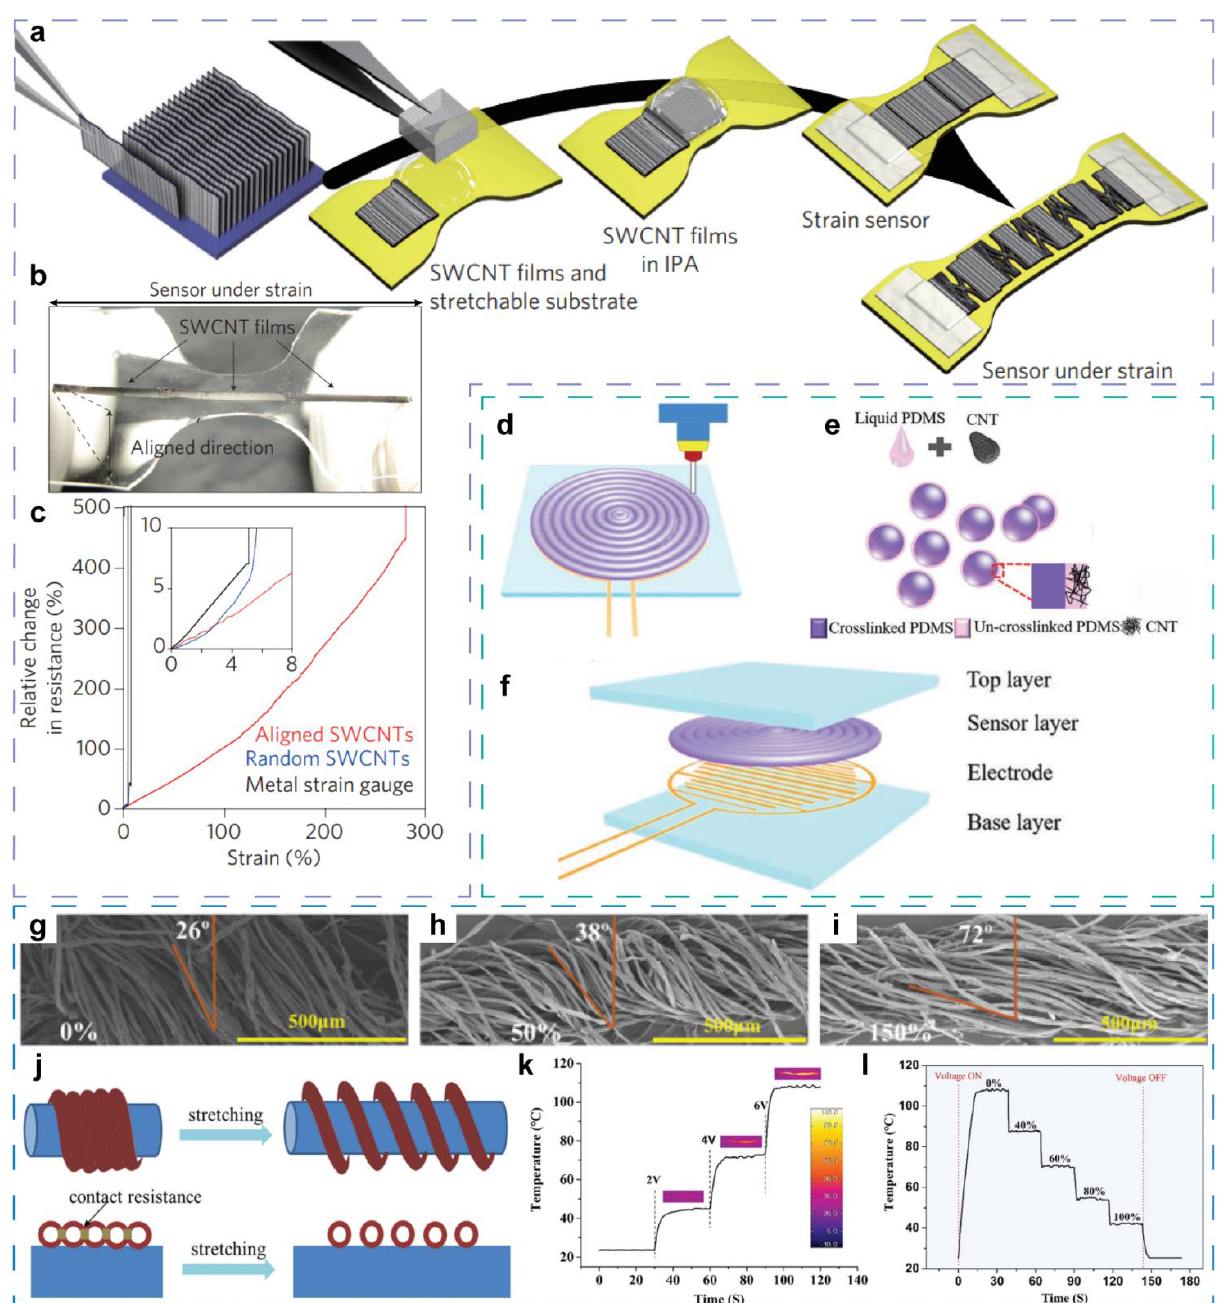
Figure 3. Multifunctional mechanical sensors employing 1-D conductive materials as sensing components. ( a ) Fabrication steps of the SWCNT strain and bending sensor. ( b ) Photograph of the SWCNT sensor. ( c ) Relative change in resistance of aligned under strain up to 280%. The inset is magnification of the low-strain region, showing the details for sensor based on random SWCNTs and conventional metal thin film. Reproduced with permission. [62] Copyright 2011, Springer Nature. ( d ) Schematic of 3D-printing method for the piezoresistive sensor based on PDMS MPs and CNTs that mimics the texture and sensitivity of human skin. ( e ) The new type of 3D-printing ink for fabricating the sensor, containing PDMS MPs, uncured PDMS precursor, and CNTs. ( f ) Structure diagram of the PDMS/CNT composite sensor. Reproduced with permission. [58] Copyright 2019, Wiley-VCH. ( g – i ) SEM image of the Ag NWs/CPY sensor under strain of 0%, 50%, and 150%, respectively. ( j ) AgNWs/CPY model for illustrating the sensing mechanism. ( k ) Temperature of the AgNW/CPY composite under increased voltage and without strain. ( l ) Temperature of the AgNW/CPY composite under voltage of 6 V and with increased strain. Reproduced with permission. [65] Copyright 2019, Royal Society of Chemistry.